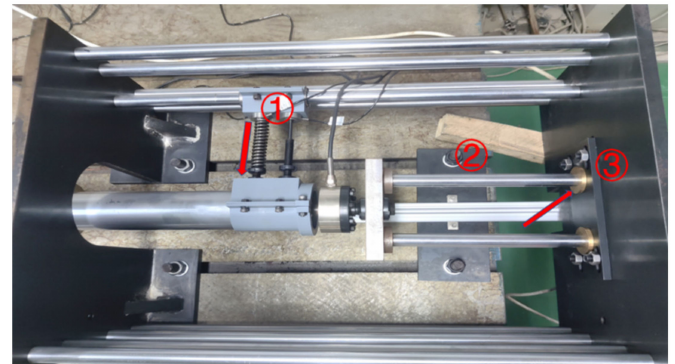
Figure 17. Diagram of loading